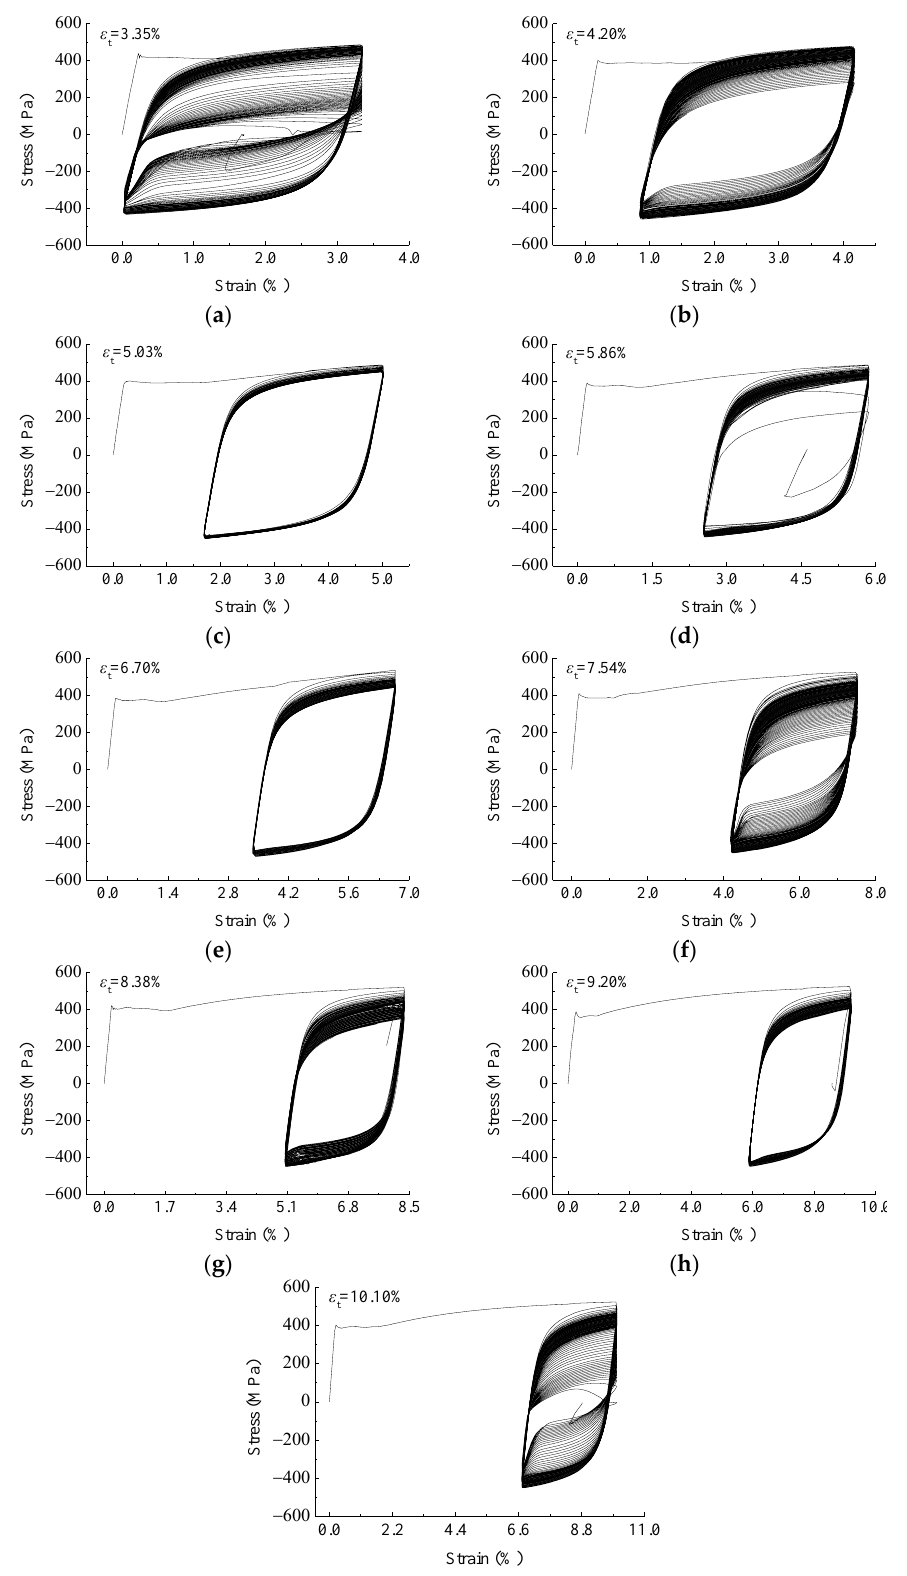
Figure 9. The stress – strain curves of tension – fatigue tests with a prior maximum tensile strain of: ( a ) 3.35%; ( b ) 4.20%; ( c ) 5.03%; ( d ) 5.86%; ( e ) 6.70%; ( f ) 7.54%; ( g ) 8.38%; ( h ) 9.20%; ( i ) 10.10%.